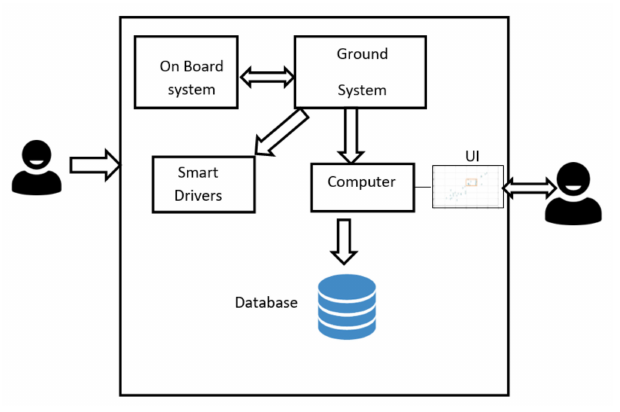
Figure 2. System